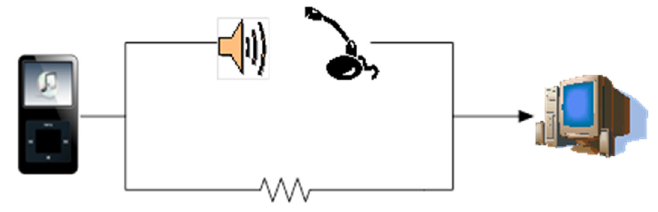
Figure 3. Two paths of recordings.